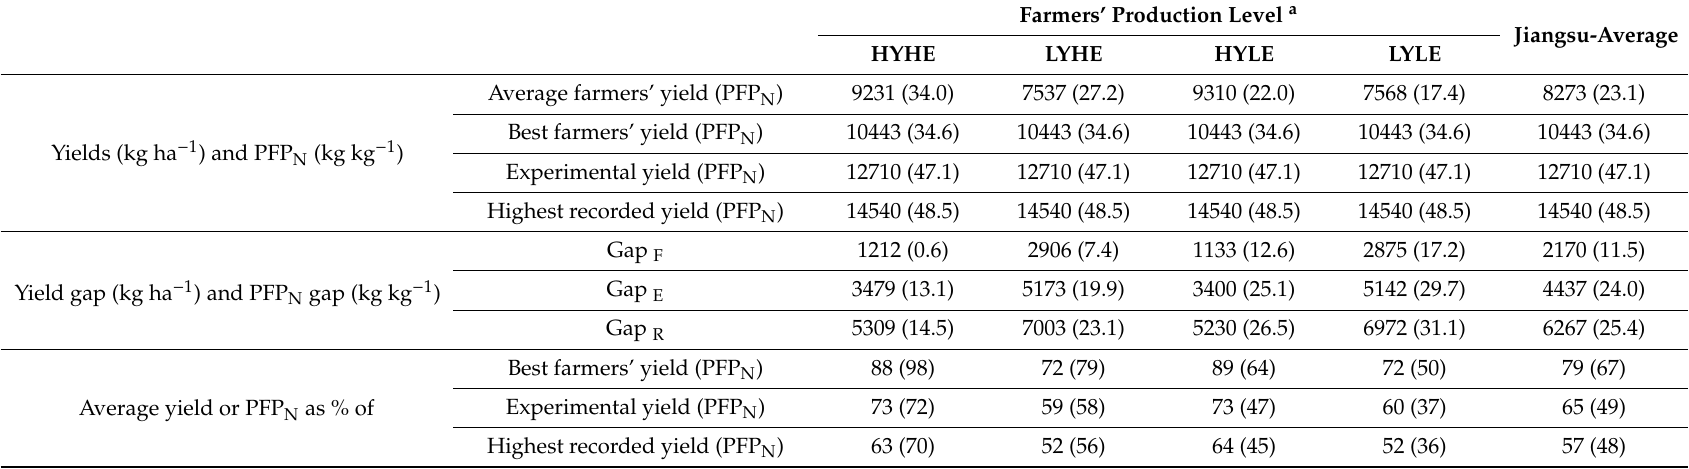
Table 2. Actual yield, yield potential and yield and partial factor productivity of applied N (PFP N ) gaps amongst farmers categorized based on production level and nitrogen use e ffi